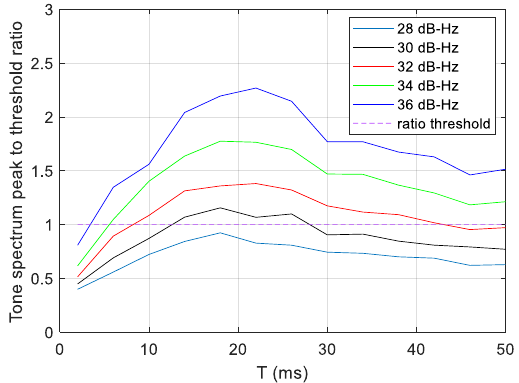
Figure 4. Ratio between the tone spectrum peak and the detection threshold as a function of the duration of the FFT burst, T, and for different C/No levels. A tone dynamic of 5 kHz/s is assumed.